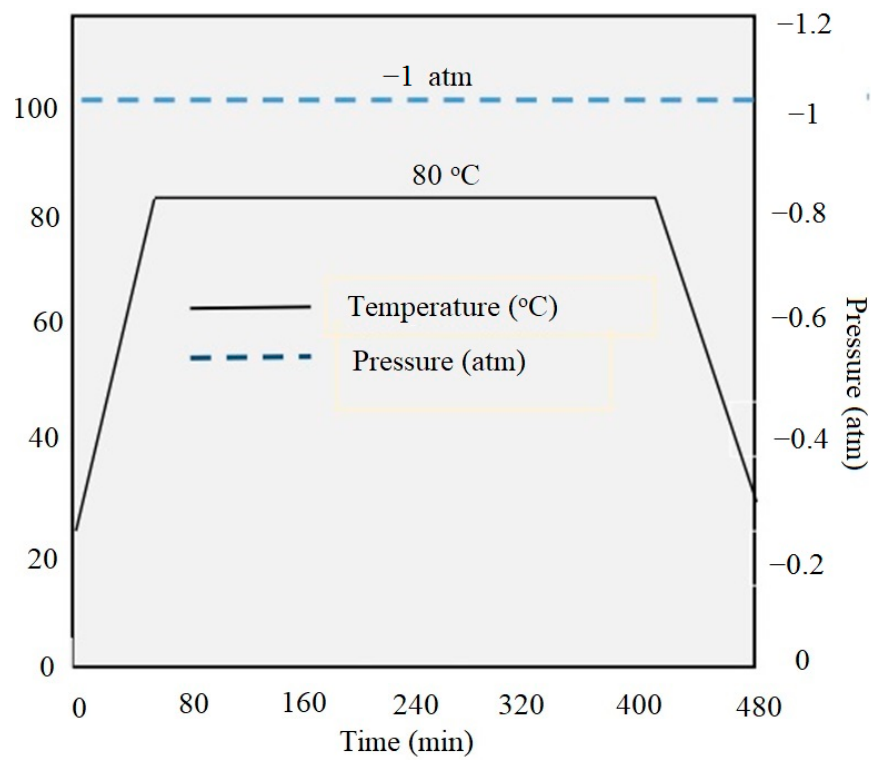
Figure 2. Schematic of curing process of fabricated CFRP composites. Table 1. Mechanical and physical properties of used materials as components in the composite structure.